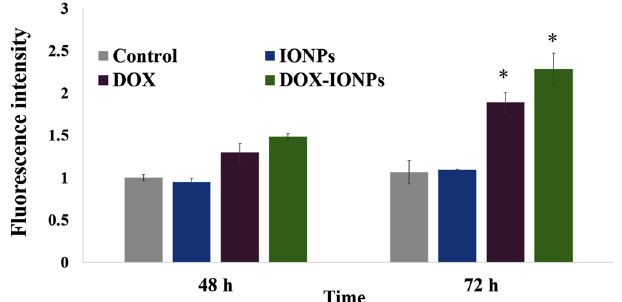
Figure 9. ROS induction by EDT-IONPs, DOX or DOX-EDT-IONPs in U251 at different time-points. *Indicates a significant difference compared to the control group at p < 0.05. Data is presented as mean ± S.D, and n = 5. IONPs and DOX-IONPs represent for EDT-IONPs and DOX-EDT-IONPs.